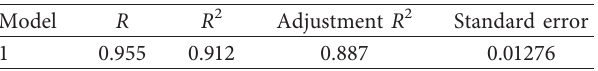
Figure 8: The correlation between VMA and voids fraction and connected voids fraction. Table 7: Model goodness-of-fit